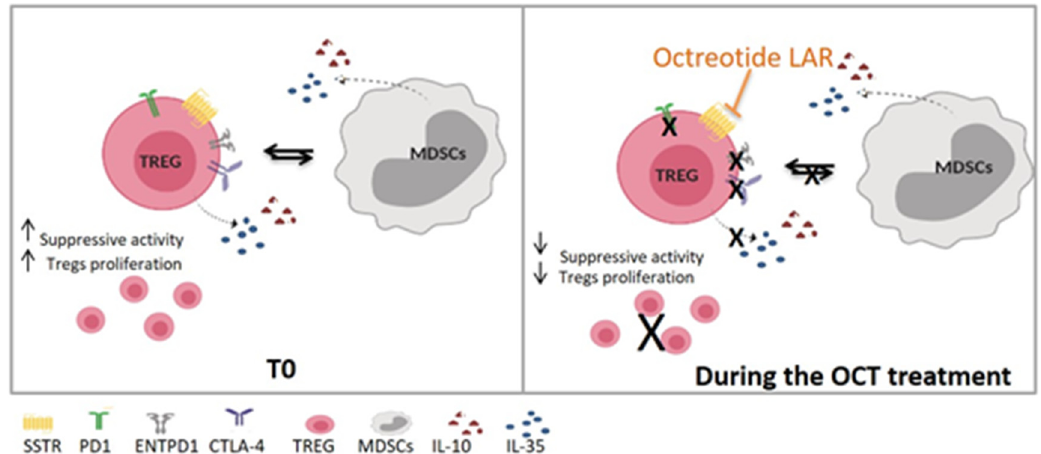
Figure 8. Proposed OCT LAR mechanism of action on immune cells. T0, Time 0—before Octreotide treatment; OCT, Octreotide.